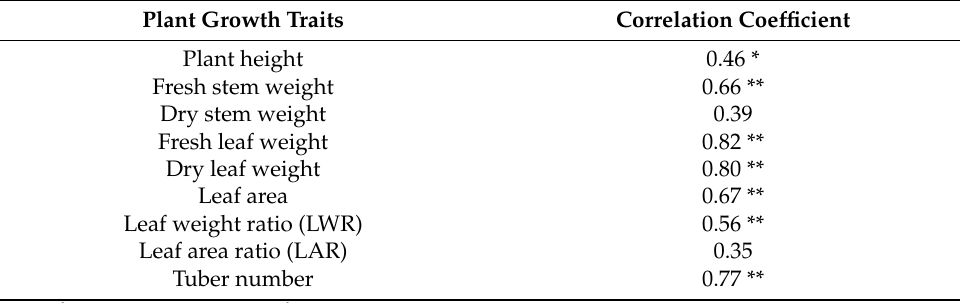
Table 8. Linear correlation coefficients (n = 21) between tuber weight per plant and plant growth